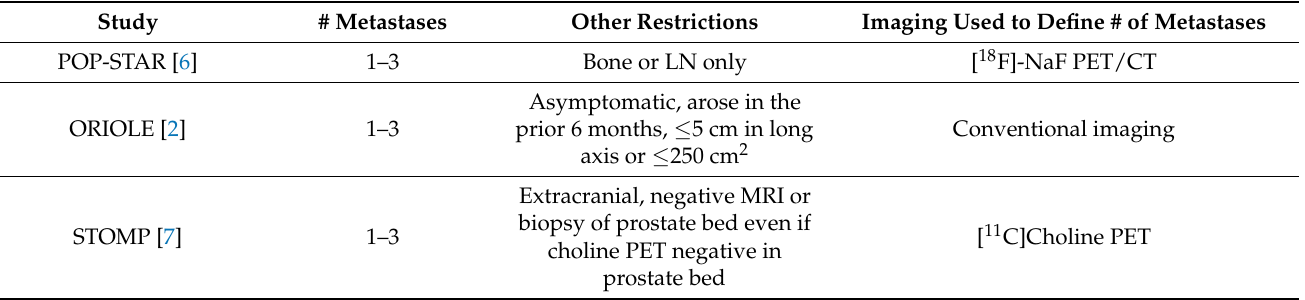
Table 2. Imaging used to qualify patients for enrollment in select published oligometastatic prostate cancer clinical